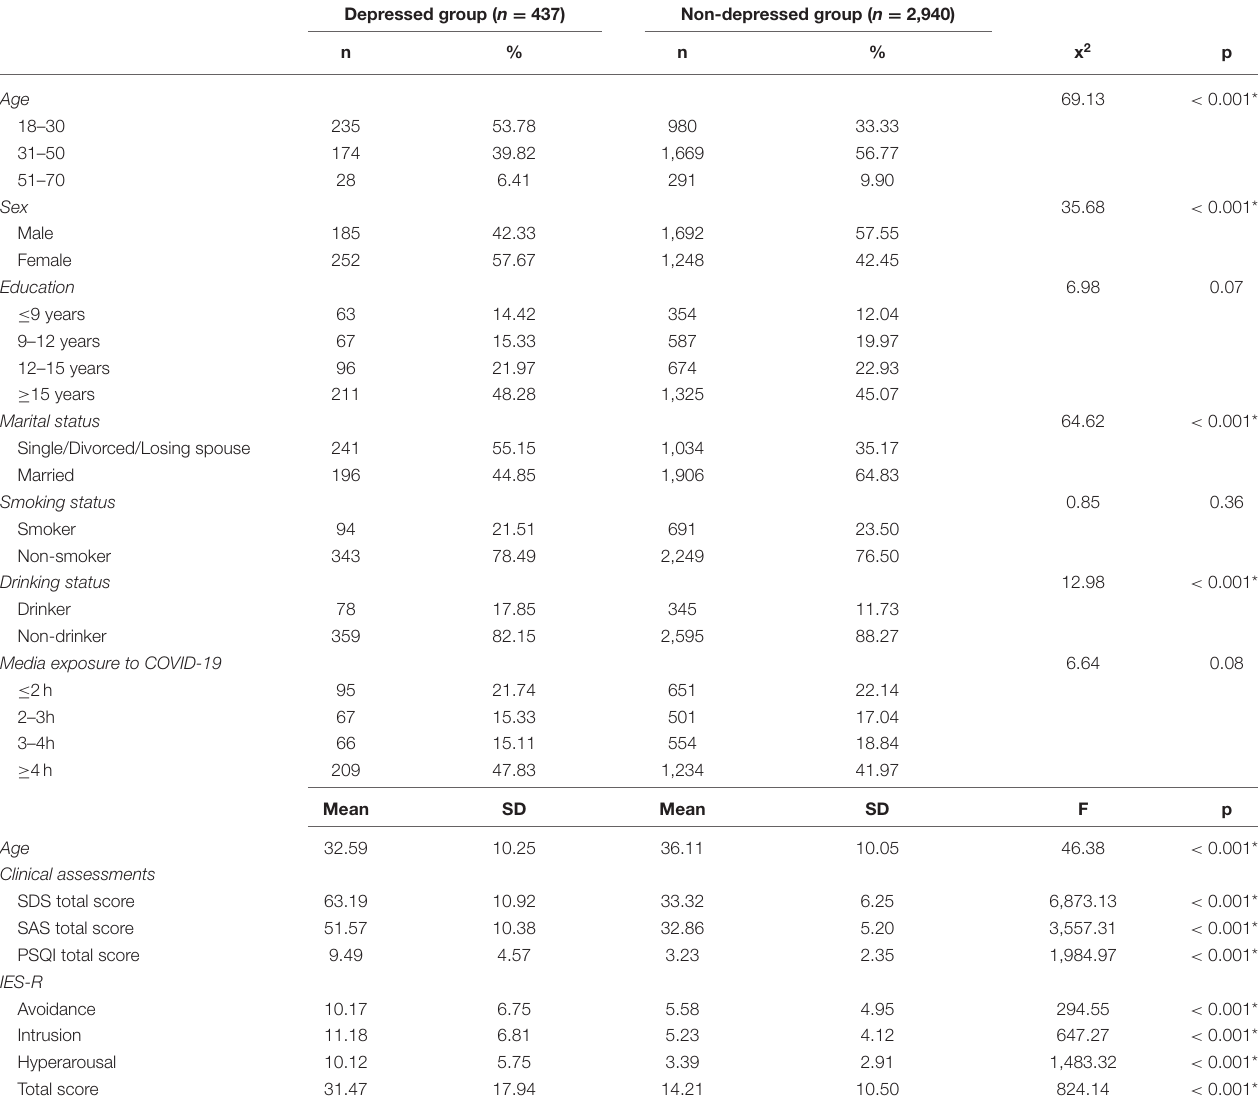
TABLE 1 | Social demography and clinical characteristics of subjects with depression and non-depressed (x 2 and MANOVA). Depressed group ( n =